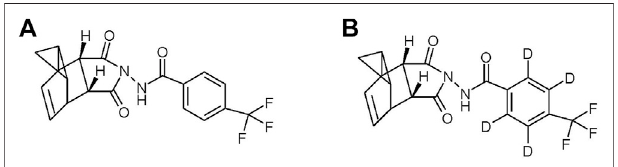
FIGURE 1 | Chemical structure of ST-246 (A) and ST-246-D4 (IS) (B)